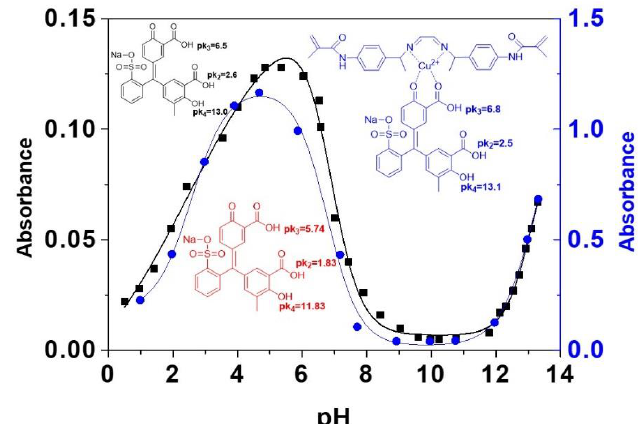
Figure 3. Red: pKa values for D according to the literature in aqueous media. Black : pH study and obtained pKa values for D in methanol:pH 7 buffer solution (1:1) media. Blue : pH study and obtained pKa values for the complex {(3)-Cu(II)}nDm (n:1, m:1) in methanol:pH 7 buffer solution (1:1) media.